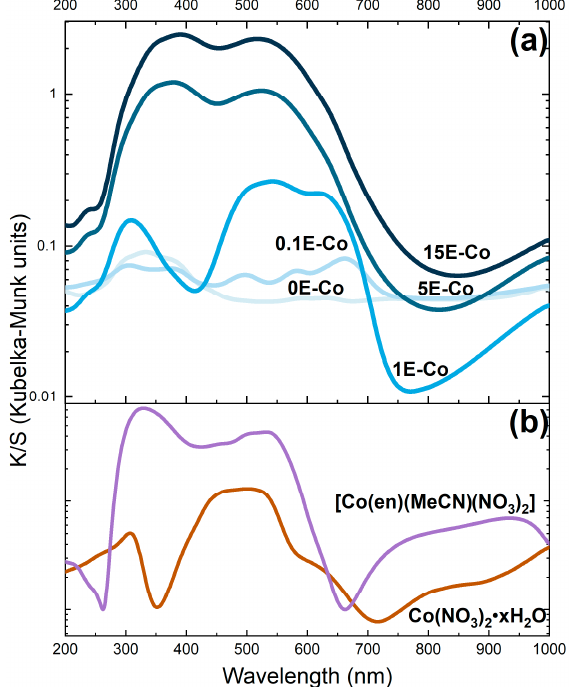
Figure 3. Diffuse reflectance spectra of ( a ) cobalt-modified aerogels, ( b ) Co(NO 3 ) 2 · x H 2 O, and [(Co(en)(MeCN)](NO 3 ) 2 ].